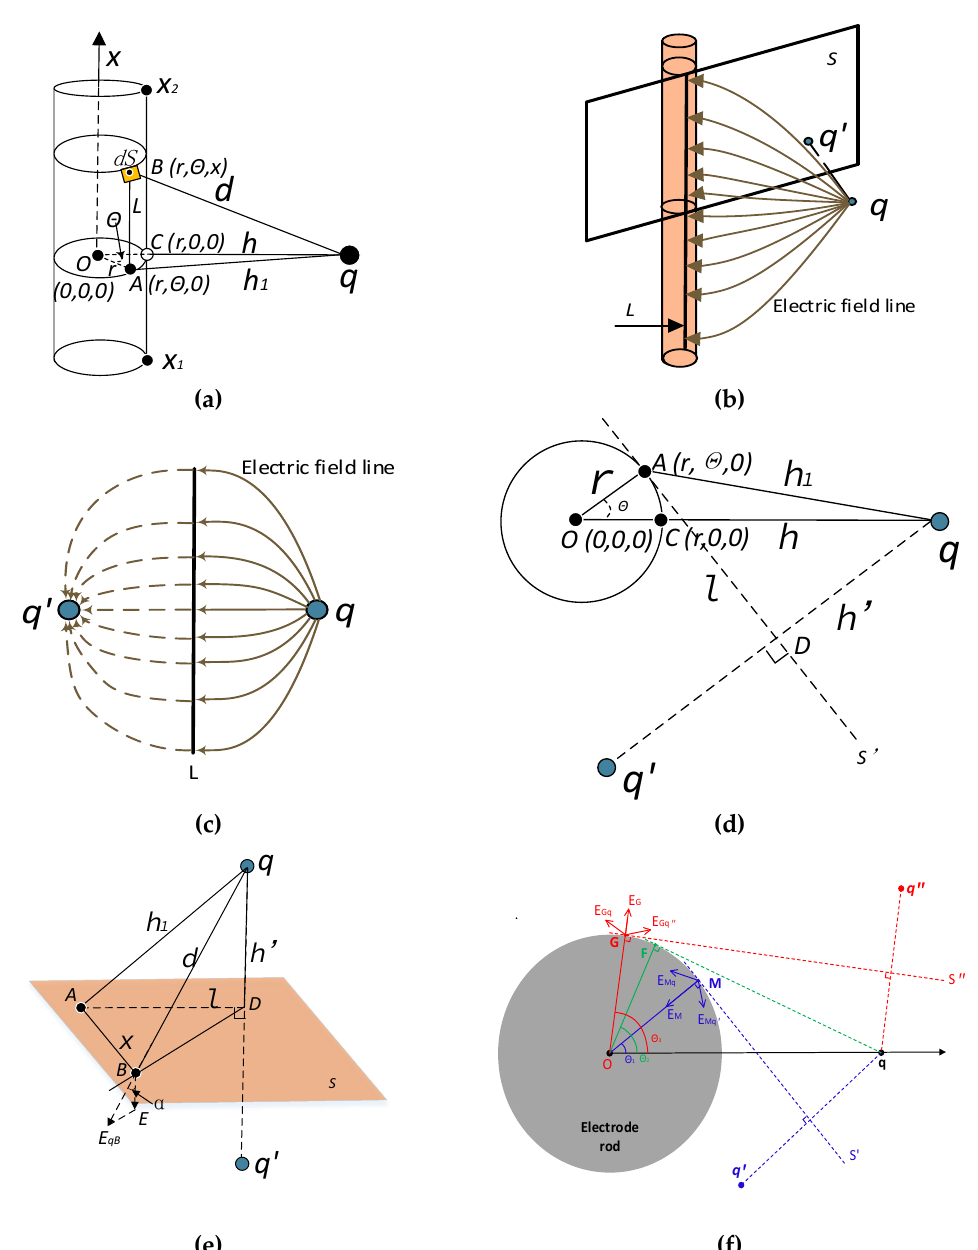
Figure 3. Rod electrode induced charge model: ( a ) Point charge q and its image; ( b ) electric field line distribution; ( c ) coordinate system; ( d ) projection of point B on plane OAC ; ( e ) calculation of the field strength of B using the image method; and ( f ) determining the range of θ .